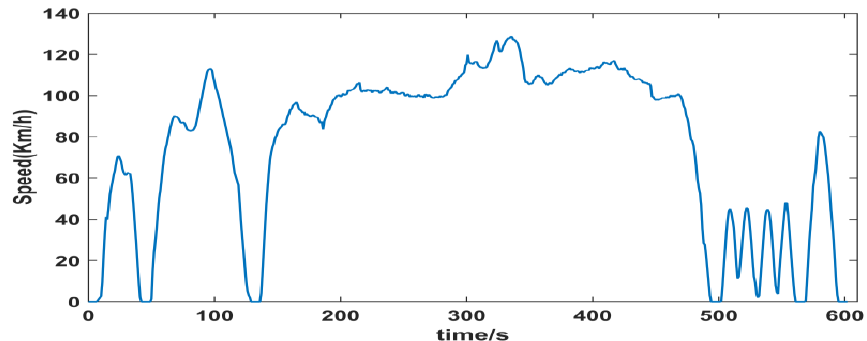
Figure 10. US06 condition.